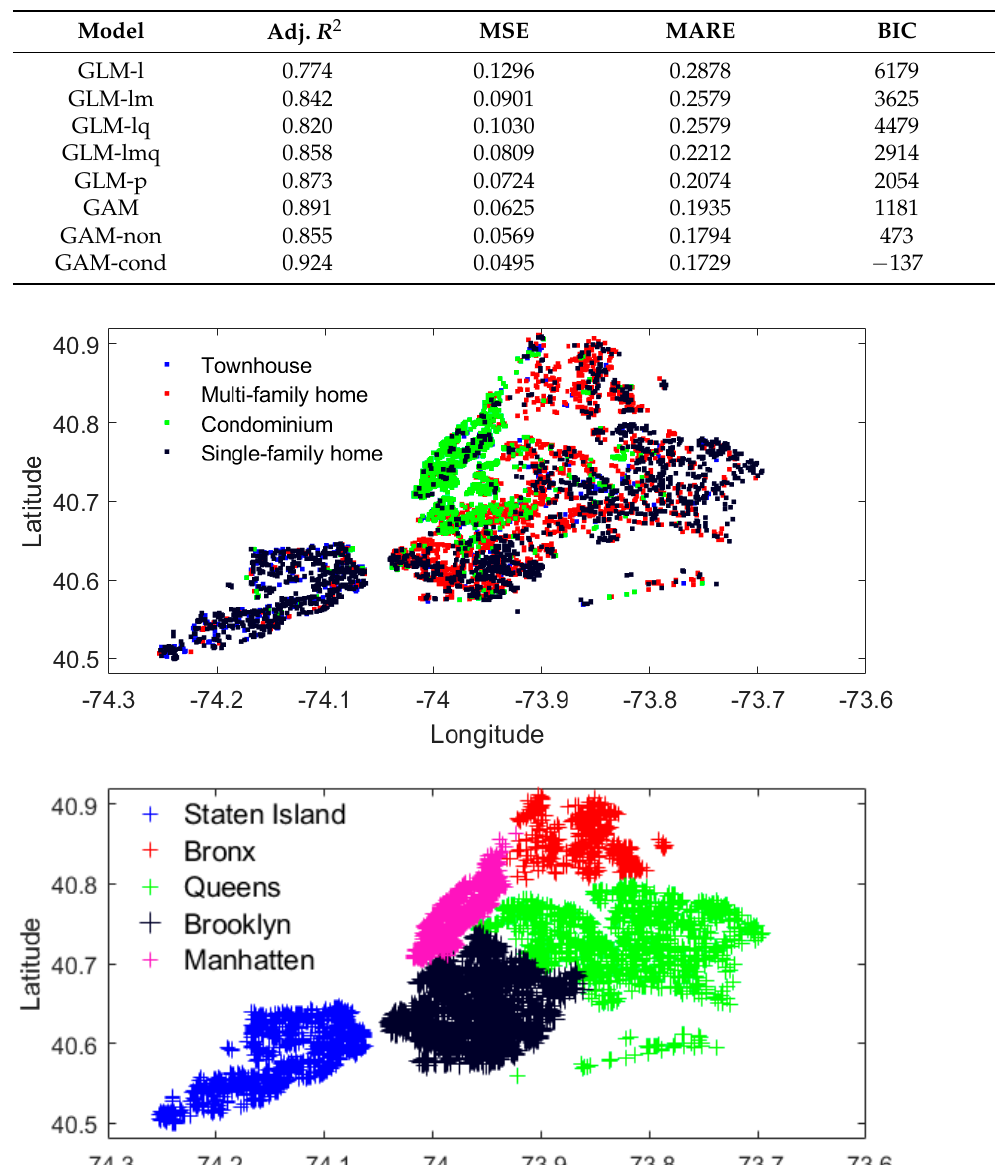
Table 3. Summary fit statistics for GLM and GAM models for NYC.